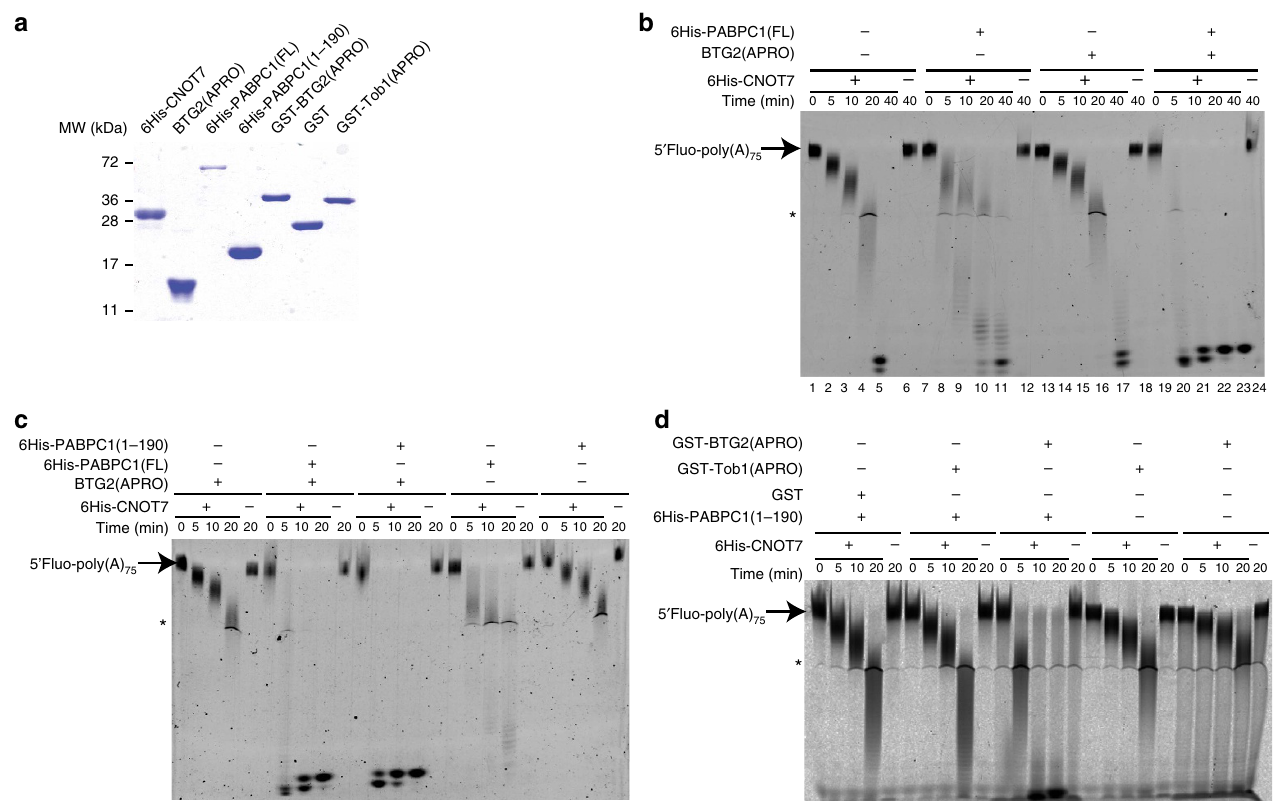
Figure 3 | BTG2 APRO domain and PABPC1 stimulates CAF1 (CNOT7 paralogue) deadenylase activity in vitro. ( a ) SDS–PAGE analysis of purified recombinant proteins used in in vitro deadenylation assays. Five micrograms of purified proteins were resolved on 12% SDS–PAGE gel stained with Coomassie blue. Reduced amount of 6His-PABPC1(FL) likely reflects inaccurate protein concentration determination because of the presence of shorter protein fragments. ( b ) In vitro deadenylation assays with CAF1 (CNOT7 paralogue), BTG2(APRO) and full-length PABPC1. A 5 0 Fluorescein-labelled poly(A) substrate of approximately 75 residues was incubated in defined conditions (see Methods), with purified 6His-CNOT7, BTG2(APRO) and/or 6His- PABPC1(FL) as indicated. Reaction products were fractionated on 8% denaturing polyacrylamide gel. HEPES present in the buffer induced an altered migration of some products (asterisk). The apparent increased size of the final product observed at the latest time points is an artefact resulting from the increased impact of the hydrophobic fluorophore on the migration of shorter RNA fragments. Experiment was performed three times. Deadenylation rates are: 1.8, 1.5, 1.9 and 14.1 nts per min for 6His-CNOT7, either alone or with 6His-PABPC1(FL), BTG2(APRO) or both, respectively. ( c ) In vitro deadenylation assays with CAF1 (CNOT7 paralogue), BTG2(APRO), full-length or first RRM domains of PABPC1. Same as in b . Altered migration of the substrate was sometimes observed at early time points, particularly in the presence of 6His-PABPC1 (1–190). This varied between experiments and is partly because of the presence of the PABPC1 proteins as it is not observed after phenol–chloroform extraction of the samples. Experiment was repeated twice. Determined deadenylation rates in nts per min are 2.1 with BTG2(APRO), 13.7 with BTG2(APRO) þ 6His-PABPC1(FL), 14.3 with BTG2(APRO) þ 6His-PABPC1(1–190), 2.8 with 6HisPABPC1(FL) and 2.0 with 6HisPABPC1(1–190). ( d ) In vitro deadenylation with CAF1 (CNOT7 paralogue), BTG2 or Tob1 APRO domains, and first RRM domains of PABPC1. Same as in b . Experiment was performed three times. CAF1 deadenylation rates in nts per min are 2.3 with GST þ 6HisPABPC1(1–190), 2.7 with GST-Tob1(APRO) þ 6HisPABPC1(1–190), 7.2 with GST-BTG2(APRO) þ 6HisPABPC1(1–190), 2.1 with GST-Tob1(APRO) and 1.7 with GST-BTG2(APRO). The stimulation by GST-BTG2(APRO) þ 6HisPABPC1(1–190) is decreased in this experiment because the GST fusion proteins were batched and not HPLC-purified, and thus contained more contaminants. empty expression vector). Three days later, the cells were analysed using flow cytometry. The results showed that for cells co-transfected with GFP and empty expression plasmid, the peaks corresponding to the proliferation dye intensities of the GFP-negative (not transfected) and GFP-positive cells precisely overlap (Fig. 5a, left panel). This indicates that these two cell populations divided with the same kinetics. By contrast, for the cells co-transfected with plasmids expressing GFP and BTG2(APRO)-HA, the peak of dye intensities for the GFP-positive cells (co-expressing BTG2 and GFP) is shifted towards higher values as compared with the peak for the GFP-negative cells (Fig. 5a, right panel). This indicates that the cells expressing BTG2(APRO)-HA proliferated more slowly than the untransfected cells. Thus, expression of the APRO domain of BTG2 is sufficient to slow cell proliferation. Generation doubling NATURE COMMUNICATIONS|7:10811|DOI: